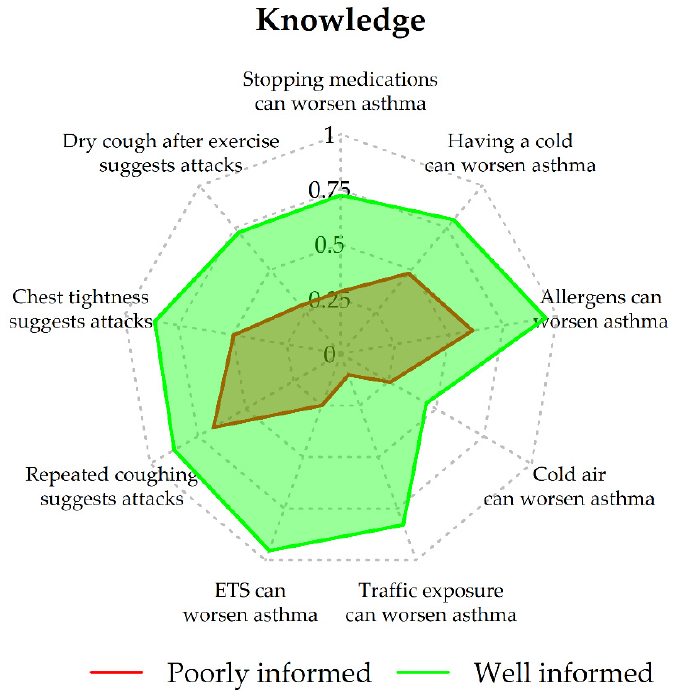
Figure 1. Knowledge: probabilities of positive response by class. ETS: environmental tobacco smoke.